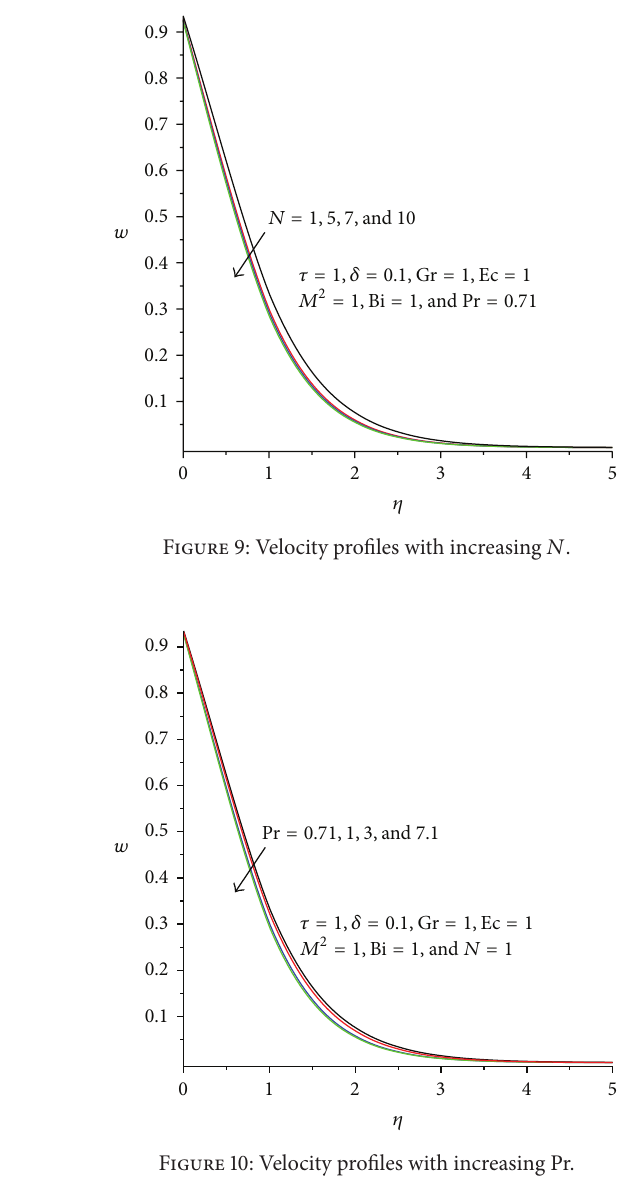
Figure 10: Velocity profiles with increasing